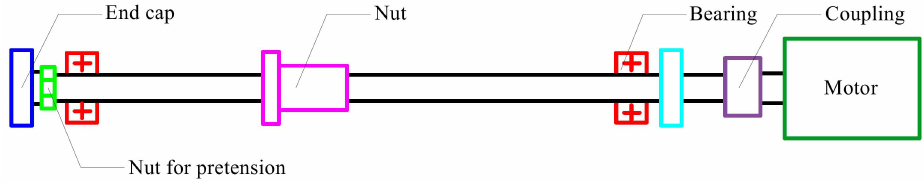
Figure 2. The improved ball screw